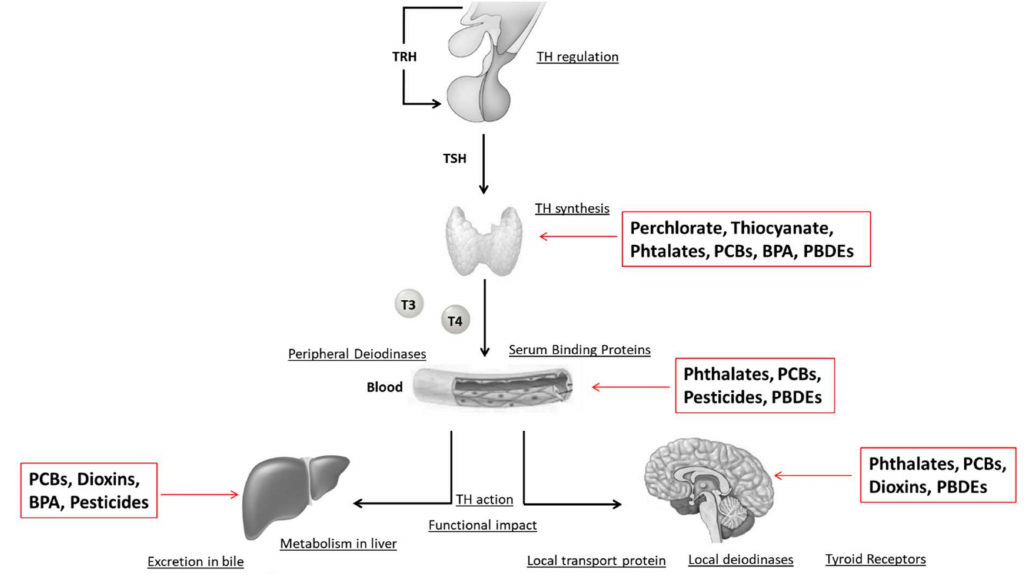
Figure 1. Action of EDCs on the HPT Axis. The black arrows indicate the endocrine axis, the red arrows indicate the organs/tissues targeted by the